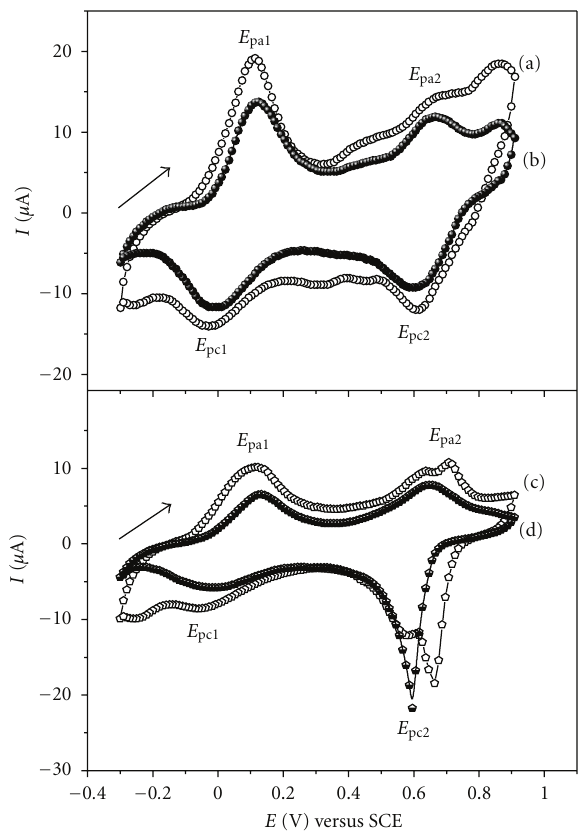
Figure 2: Cyclic voltammograms for LbL films: (a) (PANI-PA/ PVS) 6 , (b) (PANI/PVS) 6 , (c) (PANI-PA/CG) 6 , and (d) (PANI/CG) 6 in 0.1molL − 1 HCl solution at 50mVs − 1 .